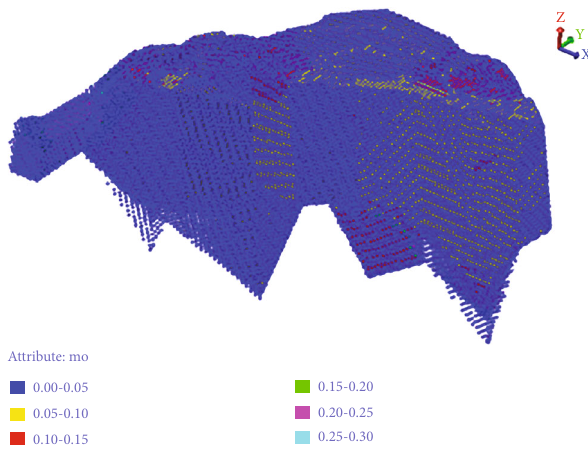
Figure 12: General kriging valuation